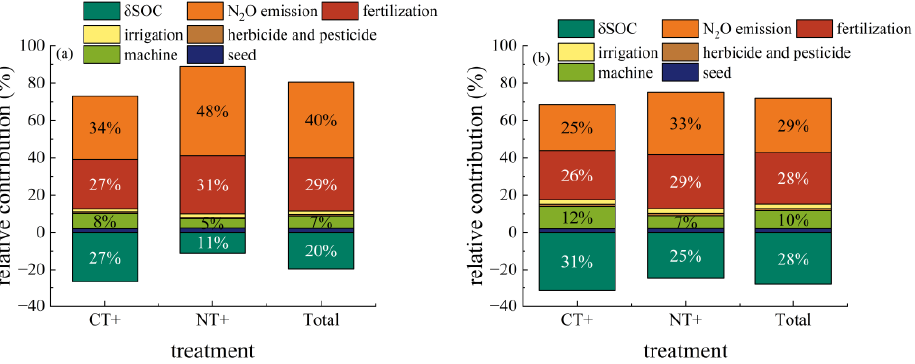
Figure 7. The relative contributions of factors to the CFa of wheat production at Wudi ( a ) and Yucheng ( b ). CT+ is crop residue incorporated into the soil with plough tillage, NT+ is crop residue mulching soil with no-till.